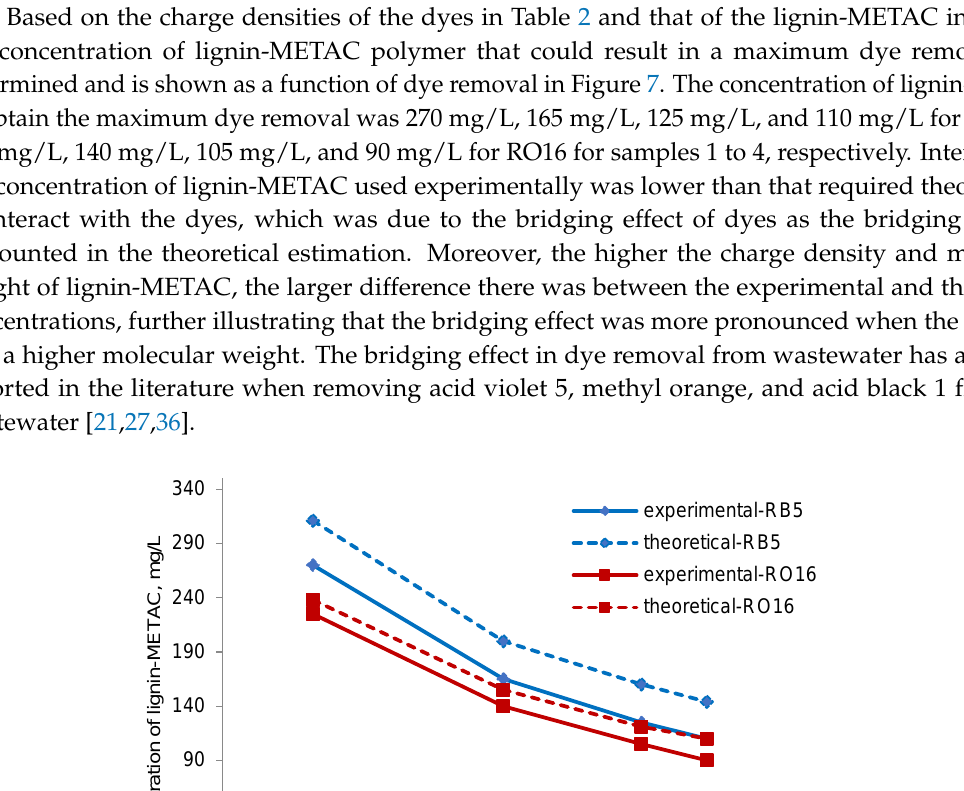
Figure 6. Effect of dosage of lignin-METAC samples with different charge densities on dye removal (100 mg/L RB5 ( a ) and RO16 ( b ) dye solution, pH 6, 30 °C).